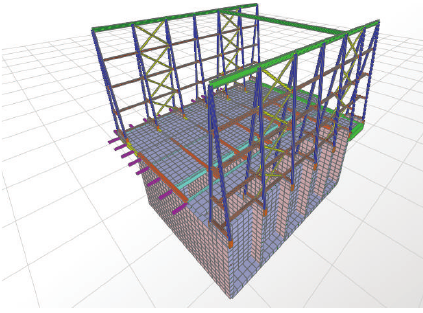
Figure 22: Structural model of train A/B.